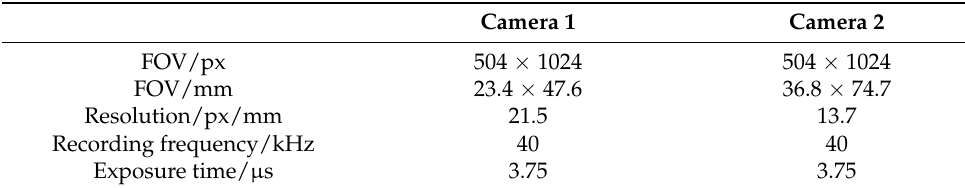
Figure 3. Visualization of the experimental setup to measure the droplet deformation inside the orifice and right behind the orifice with two high-speed cameras; camera 1 (Cam 1) focused on the orifice, and camera 2 (Cam 2) focused on the space behind the orifice. Table 1. Image acquisition properties for the two cameras.